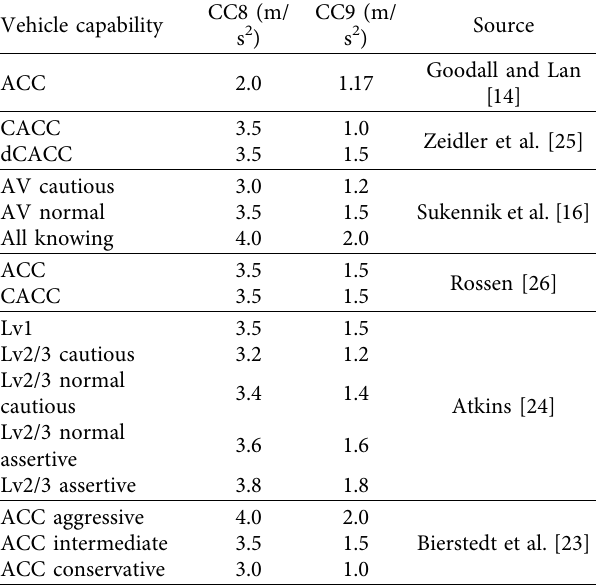
Table 5: Standstill acceleration (CC8) and acceleration at 80km/h (CC9) values for the Wiedemann 99